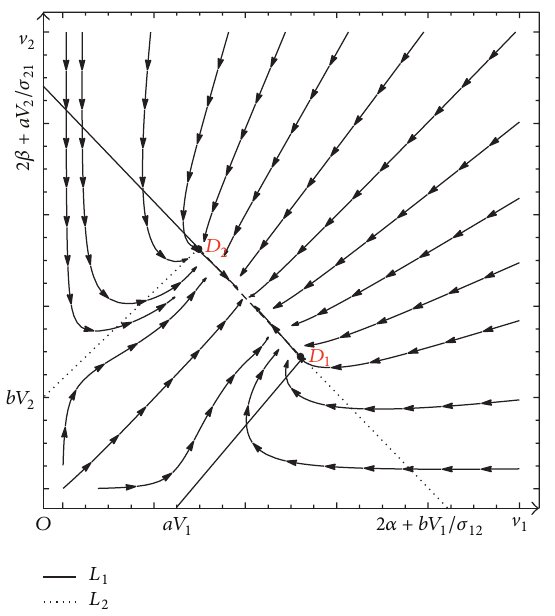
Figure 6: Equilibrium points on the line segment 𝐷 1 𝐷 2 .